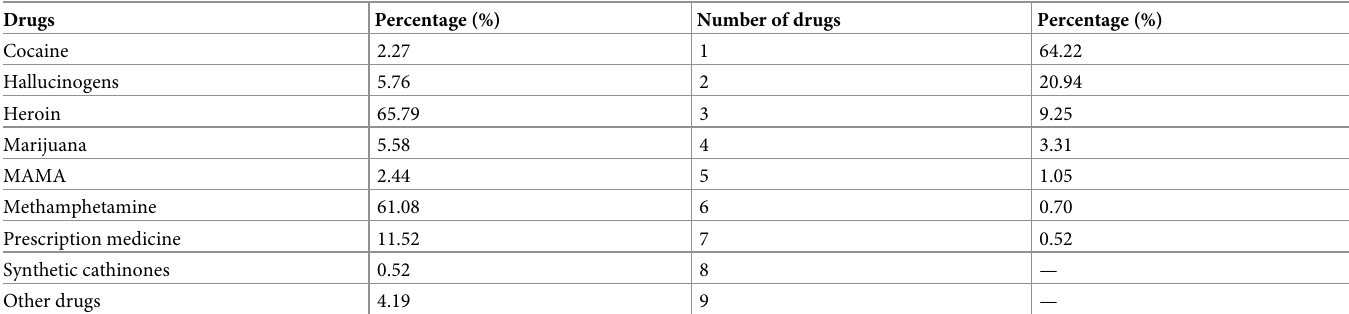
Table 1. Distribution of drug categories.